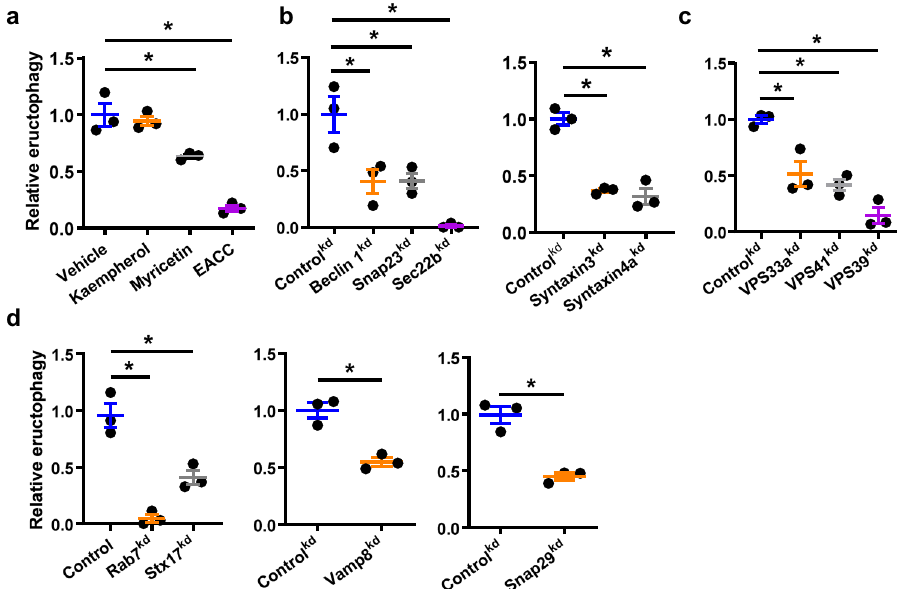
Fig. 6 Speci fi c SNAREs, Rabs and Syntaxins mediate eructophagy. a – d Eructophagy was detected by hydrolysis of the membrane impermeant substrate resoru fi n maltotriose by α -amylase conjugated to 3.0 μ m reporter particles within phagolysosomes between 1 – 3 h following phagocytosis by a WT GB8 macrophages or b – d GB8 macrophages with the indicated shRNA-mediated knockdown precursor-derived macrophages. Data are presented as relative to control (Elastase 2 kd ). a Cells were treated with SNARE inhibitors (10 nM myricetin, 10 nM kaempherol or 100 nM EACC) 1 h post-phagocytosis. a – d n = 3 per group. a – d Error bars presented as means ± SEM. a – d * P ≤ 0.05 by one-way ANOVA with Bonferroni ’ s post hoc test or d P ≤ 0.05 by Student ’ s two- tailed unpaired t -test when comparing two groups. P = 0.0039 Control kd vs. Vamp8 kd and P = 0.0026 Control kd vs. Snap29 kd . Source data are provided as a Source Data fi